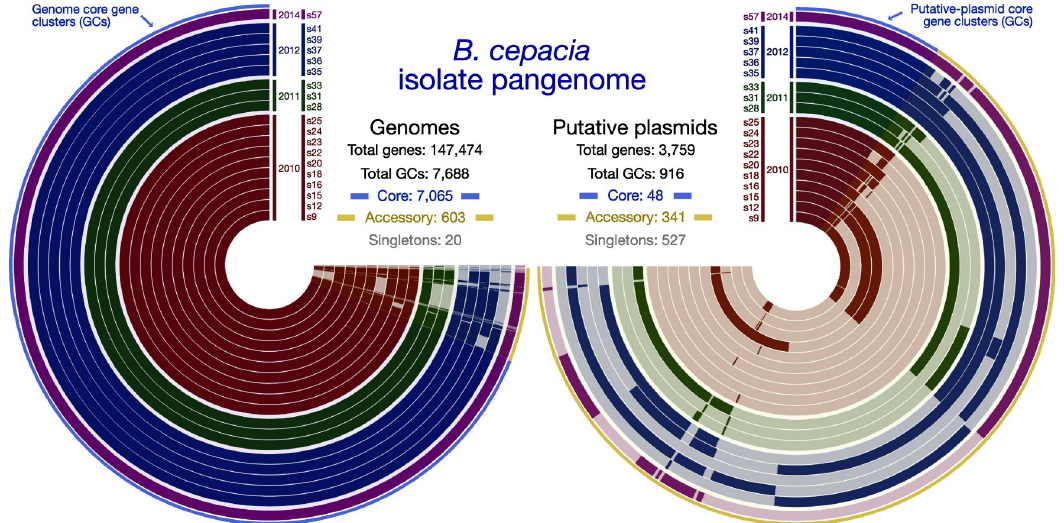
Fig 3. Pangenomics visualizations of the 19 ISS B. cepacia isolate genome assemblies (left) and identified putative plasmids (right). Each concentric circle radiating out from the center represents an isolate, identified at the top of each next to the year they were isolated. Wrapping around the circles are the generated gene clusters (GCs), where a solid mark for an isolate at a given GC indicates that particular isolate contributed a gene to that gene cluster, and the absence of a solid color indicates that isolate did not contribute a gene to that gene cluster. The very outer layer of each is a blue and yellow line. The blue line highlights core gene clusters. The yellow line highlights accessory GCs. The putative-plasmid pangenome on the right does not include singletons in the